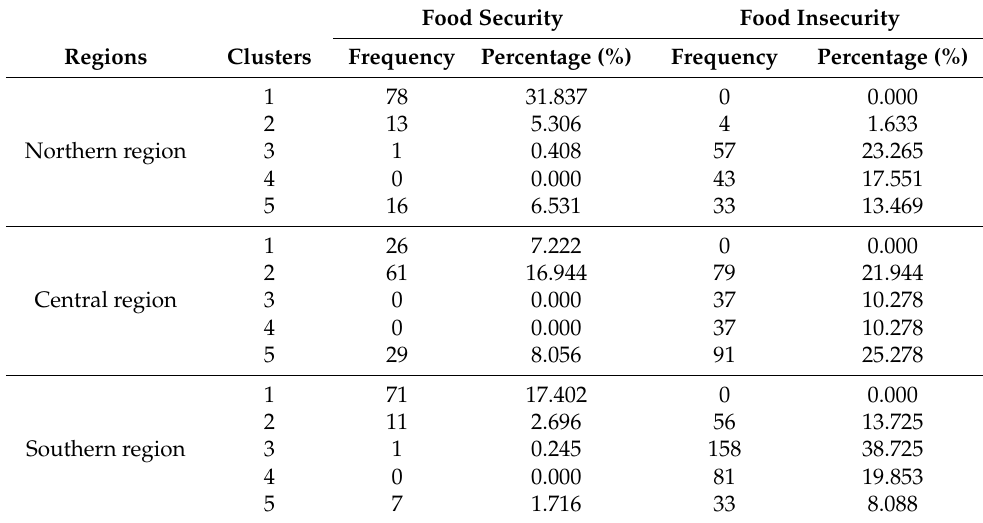
Table 7. Impact of drought on farmer food security.